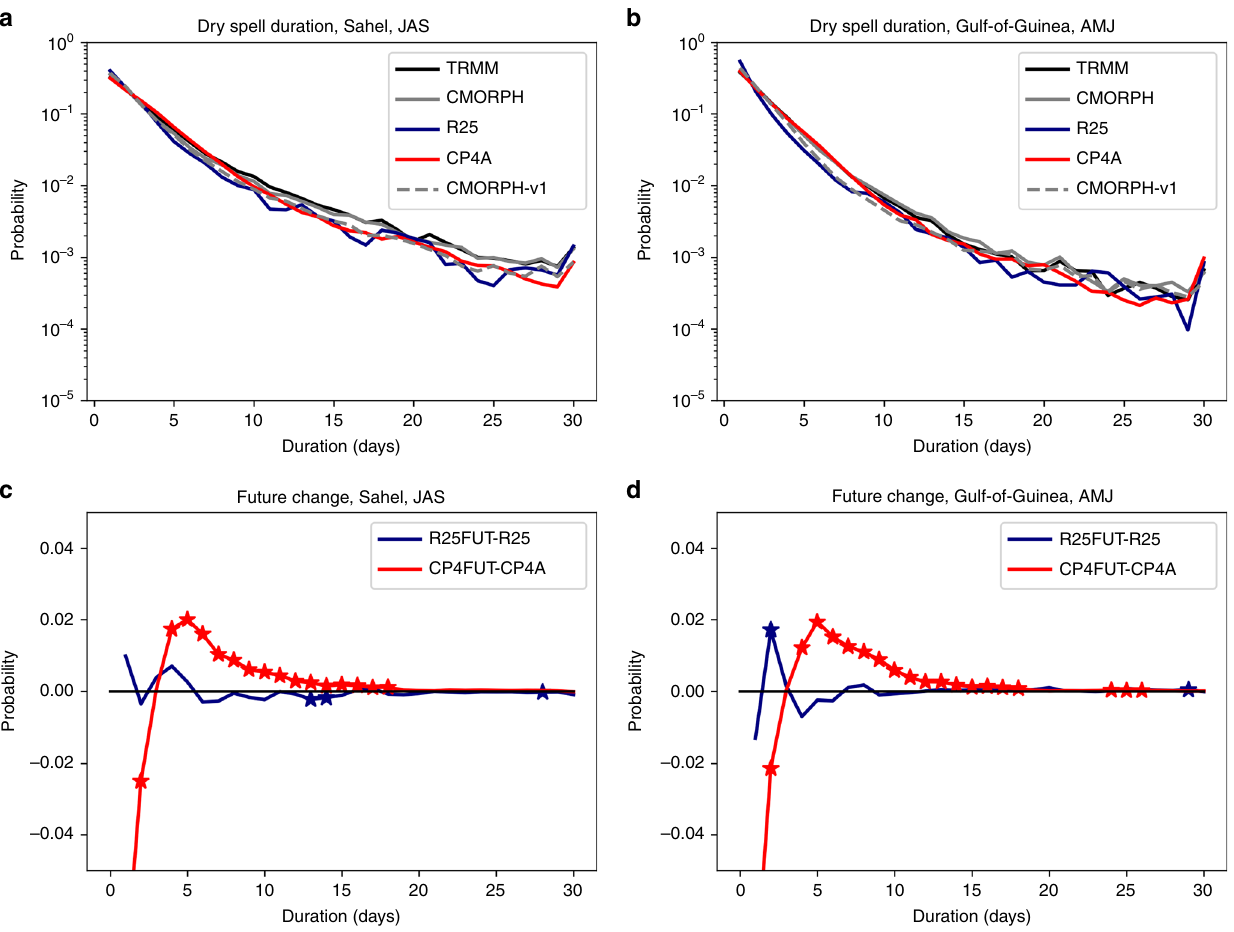
Fig. 8 Probability distribution of dry spell duration. a , b Present-day duration of dry spells for TRMM and CMORPH observations and R25 and CP4A models; c , d differences in dry spell distribution between 2100 and present day for R25 and CP4A models for Sahel July – August – September (JAS) and Gulf- of-Guinea April – May – June (AMJ). Dry spells are de fi ned as days with <1 mm of rainfall. For CMORPH, the original version 1 of the data (CMORPH-v1, grey dashed) is shown as well as the bias-corrected data (CMORPH, grey solid). Regions are as shown in Fig. 6. All daily data in the given season, in the 10-year period, from all land points in the sub-region are used to calculate the distribution. Stars indicate where future changes are signi fi cant at the 1% level compared with year-to-year variability, assessed using bootstrap